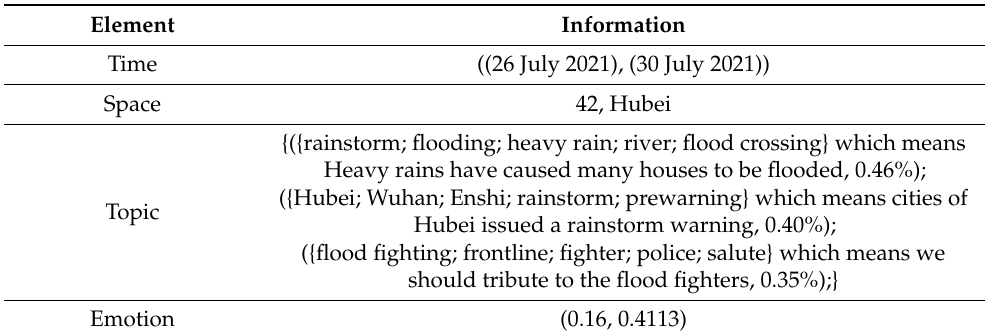
Table A2. Element information of phase2 entity of Hubei Province